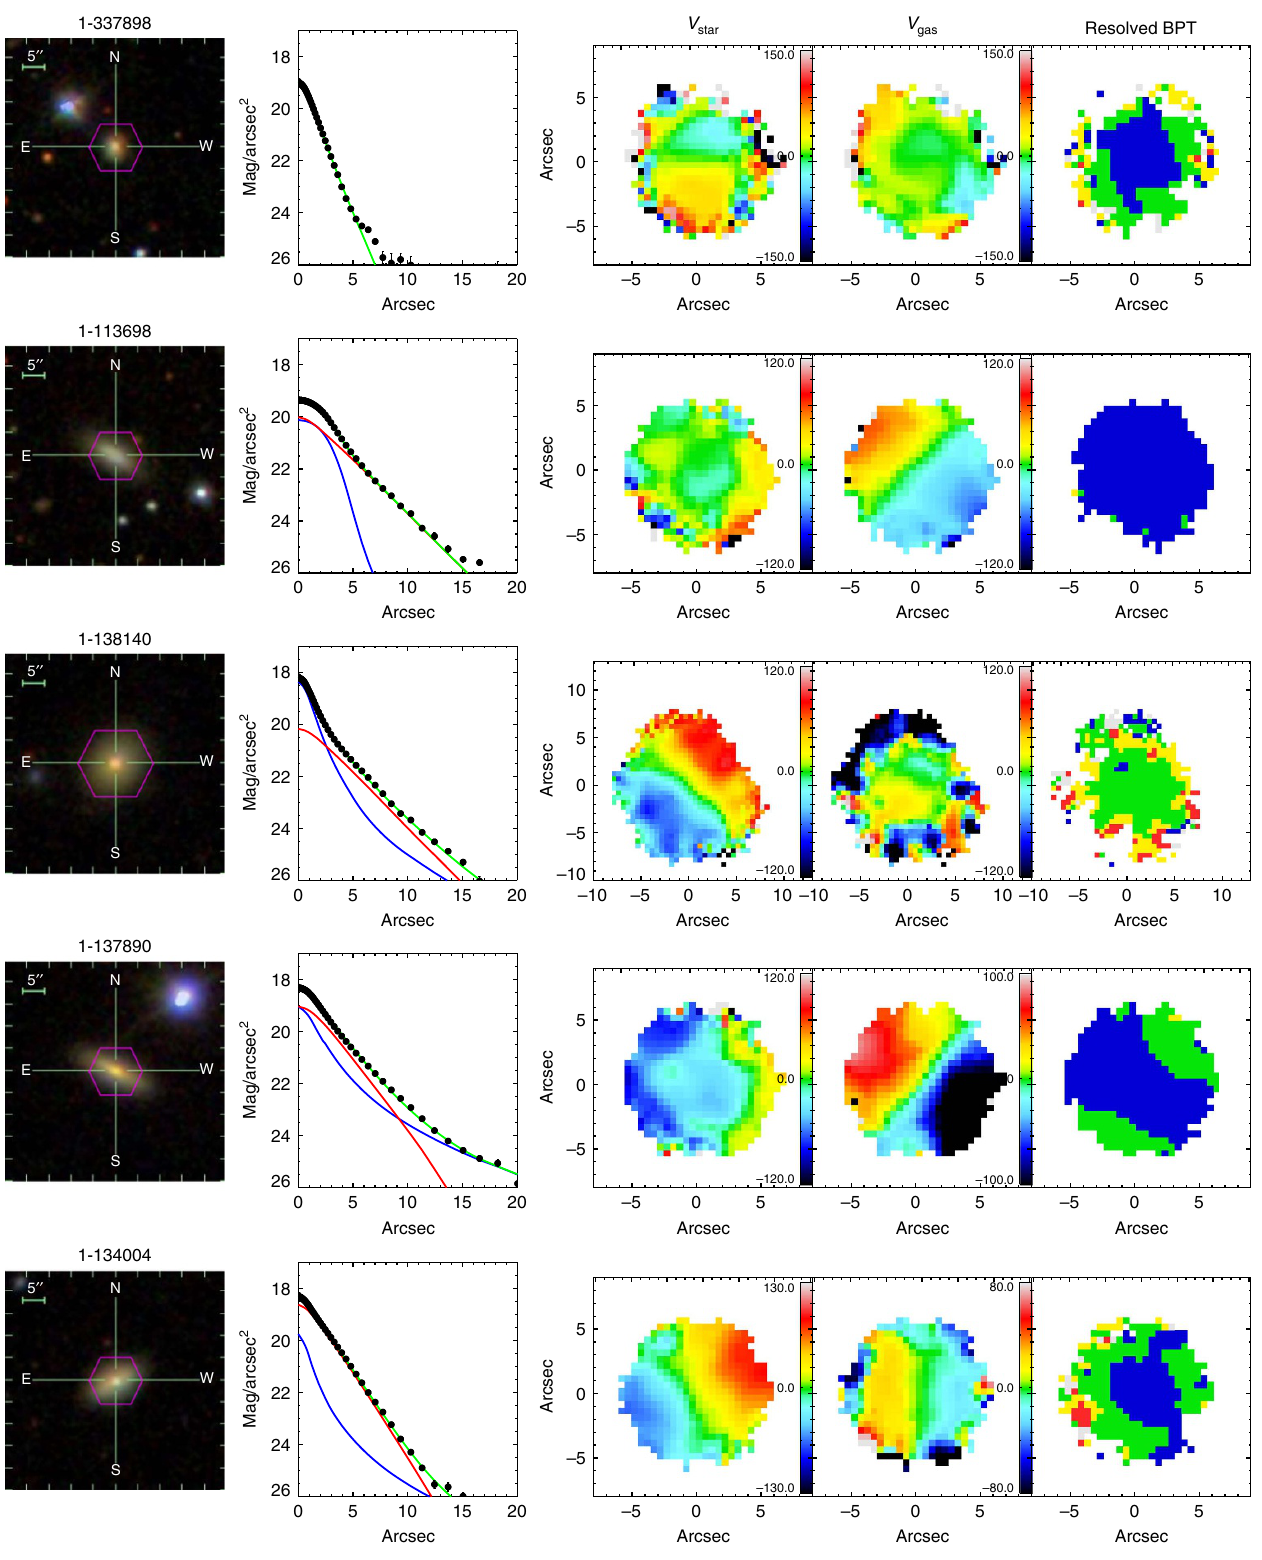
Figure 6 | Properties of the blue counter rotators. Left: the SDSS false-colour image; second column: the surface brightness profile, black is the data, green is the best fit model. Except for the first object, all the others are fitted by two components (red þ blue); the third and fourth columns show the velocity fields of stars and gas, respectively. The velocities are in the unit of km s (cid:2) 1 . The spatial resolved BPTdiagram 20 is shown in the last column, blue represents star forming region, red represents Seyfert, green is the composite of AGN and star formation and yellow represents Low-Ionization Emission- line Region